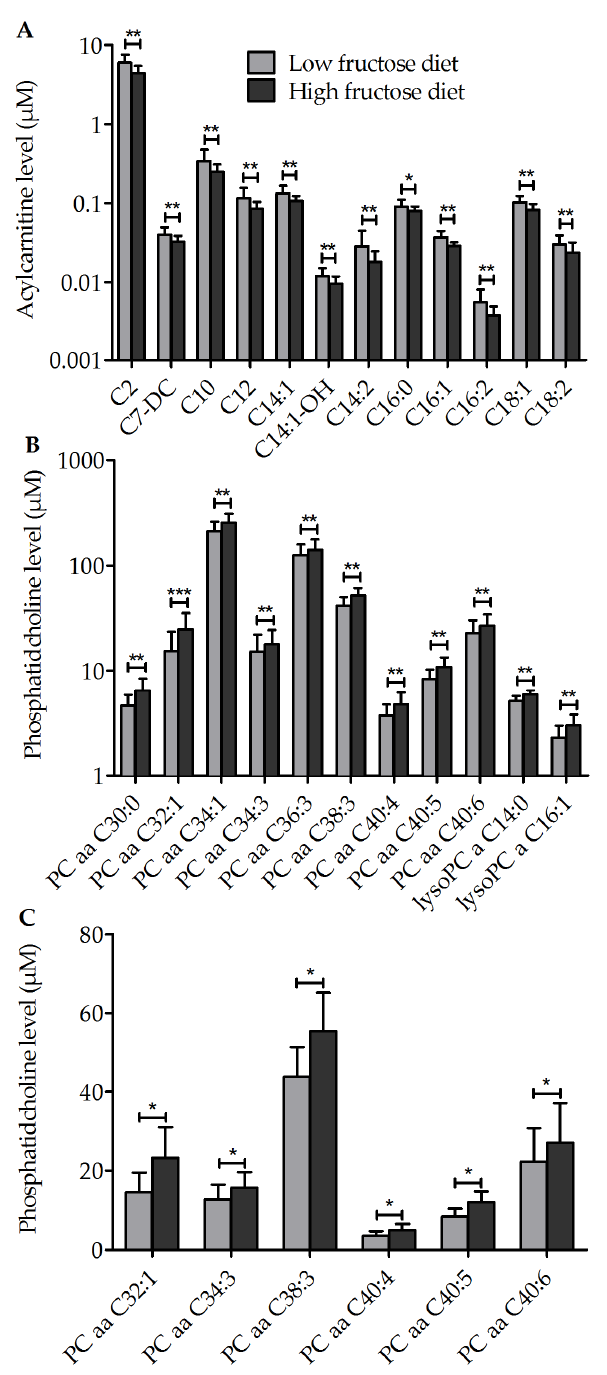
Figure 4. Significant differences in metabolites between the low fructose diet (1 + 2) and high fructose diet (fruit + HFS). ( A ) + ( B ) all ( n = 12), ( C ) obese ( n = 6) subjects, data are shown as mean ( ± SD). Significant differences between low fructose and high fructose phases are indicated as * adj. p < 0.05 and ** adj. p < 0.01. Abbreviations: lysoPC, lysophosphatidylcholines; PCaa, diacyl- phosphatidylcholine.